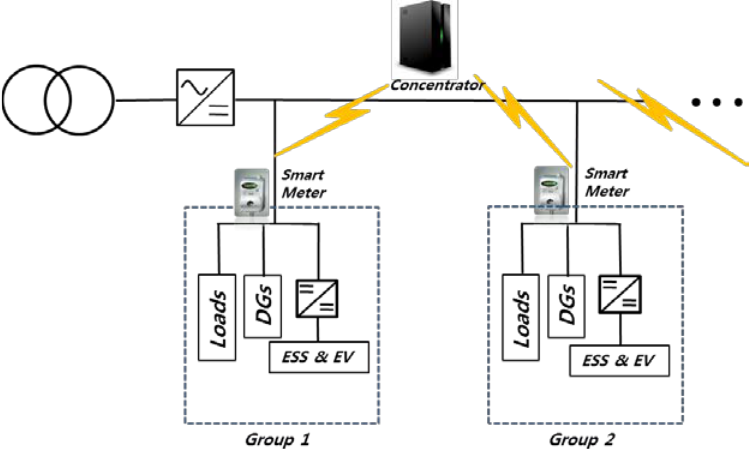
Figure 6. Configuration of the distribution system equipped with a smart metering